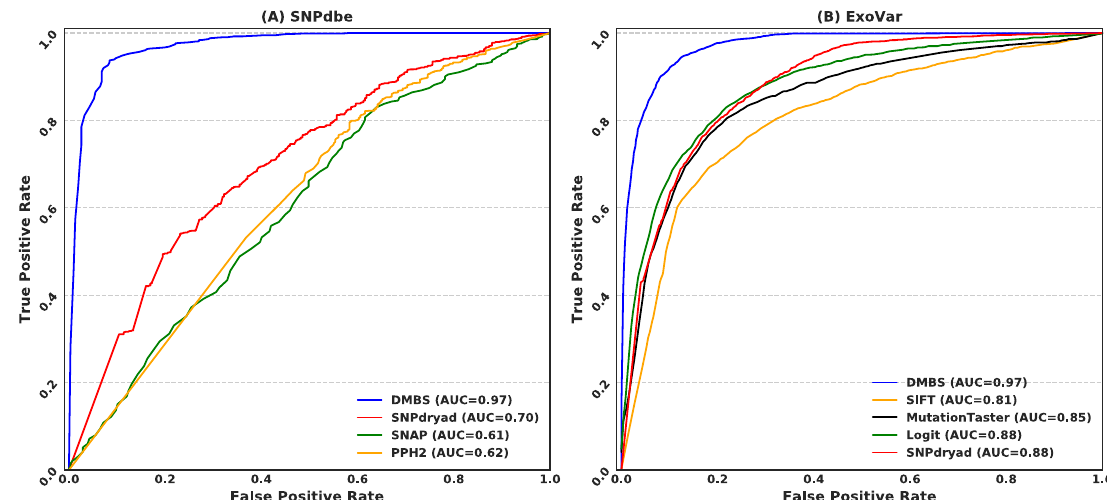
Figure 5. ROC curves and the corresponding AUC values for DMBS and six state-of-the-art predictors on the SNPdbe dataset ( A ) and the ExoVar datasets ( B ). The ROC curves for the six predictors were adopted from the work SNPdryad.